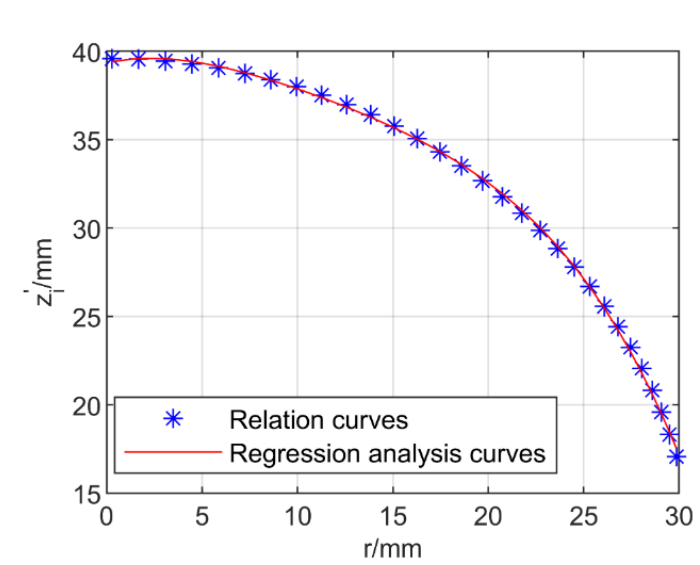
Figure 5. Regression analysis of the relation curves. The coefficients a 1 to a 5 in Equation (11) can be determined via regression analysis. According to Equations (9) and (11), when the coordinate position x i , y i is given, the distance z (cid:48) i can be obtained. Through Equations (6) and (8), θ can be expressed as Equation (12):